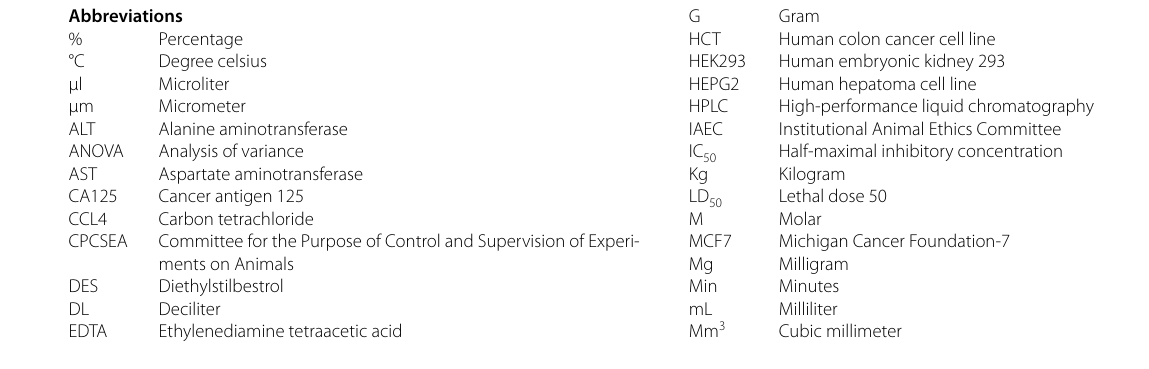
Fig. 15 Histopathological study of cervical cancer induced in Wistar albino rats. Histopathological analysis of cervical tissue. Nests of neoplastic squamous cells are regenerated (arrow head). The cancer is poorly differentiated and keratinizing (original magnification nodes are no damaged in 20 and 40 mg of TRV. Columnar glandular cells and other surrounded by normal lymphocytes (original magnification ×